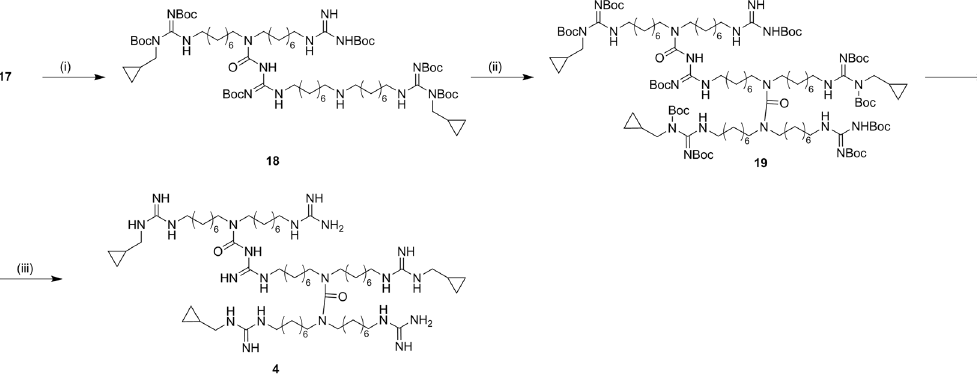
Figure 8. Synthesis of symmetric trimer ( 4 ). Reagents and conditions : (i) CAN,CH 3 CN/H 2 O, r.t., 16 h; (ii) 11 , DIPEA, NaI, dry DCM, ref., 8 h; (iii) TFA 10%, dry DCM, r.t., 7 h.